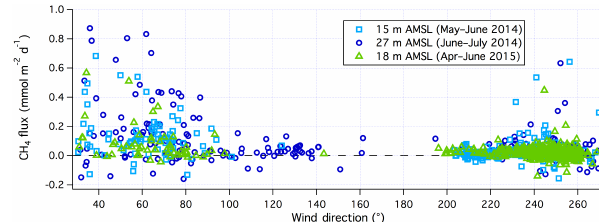
Figure 15. Hourly CH 4 flux as a function of wind direction at all three sampling heights. Larger CH 4 emissions are generally ob- served when winds are from the north-east (direction of Plymouth Sound) compared to from the south-west (open water), likely due to elevated seawater CH 4 concentrations in the estuarine outflow.